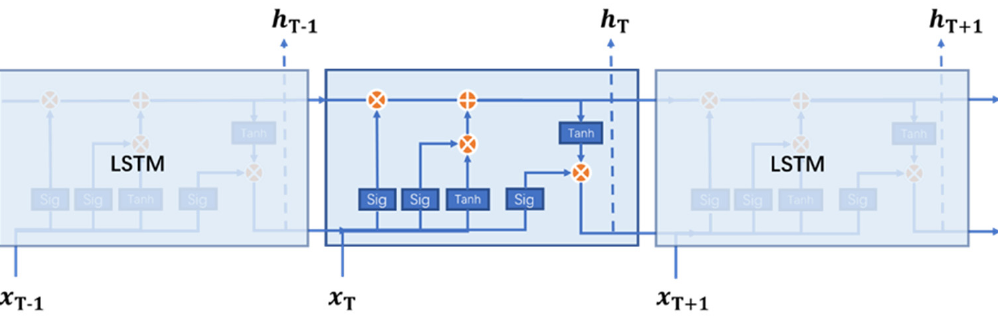
Figure 10. Our LSTM chain structure.